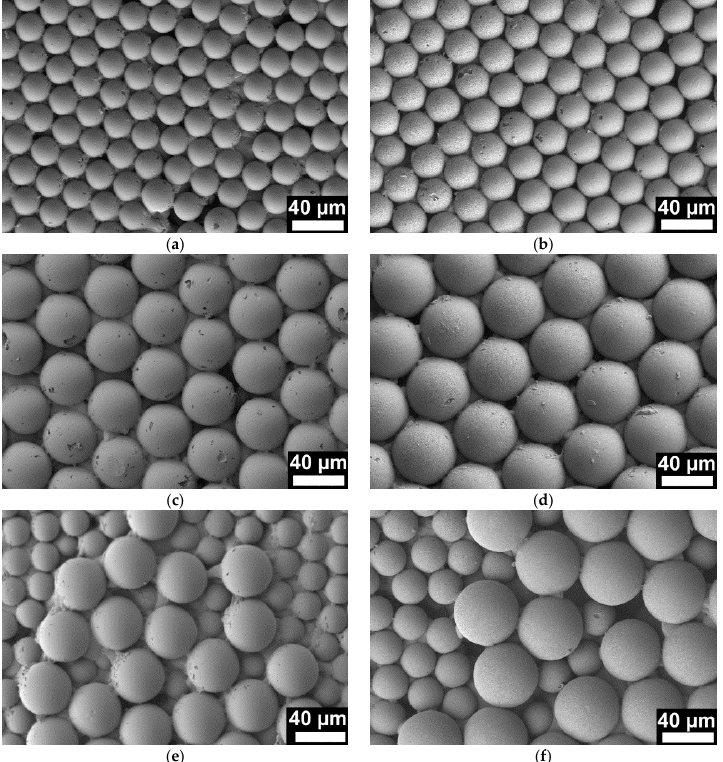
Figure 2. Scanning electron microscopy images of ( a ); ( c ); ( e ) solid monolithic arrays of PS- b -P2VP microspheres and of ( b ); ( d ); ( f ) NMMAs. The solid monolithic arrays of PS- b -P2VP microspheres shown in panels ( a ), ( c ) and ( e ) are positive replicas of the PS microsphere arrays displayed in Figure 1 that were used as primary molds. ( b ) NMMA-12.5 obtained from the solid monolithic array of PS- b -P2VP microspheres with r s = 12.5 µm displayed in panel ( a ). ( d ) NMMA-22.5 obtained by swelling-induced pore generation from the solid monolithic array of PS- b -P2VP microspheres with r s = 22.5 µm displayed in panel ( c ). ( f ) NMMA-12.5/22.5 obtained by swelling-induced pore generation from the solid monolithic array of mixed PS- b -P2VP microspheres with r s values of 12.5 µm and 22.5 µm displayed in panel ( e ). All images have the same magnification.